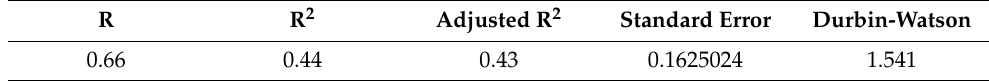
Table 3. Summary of the MLR model developed.